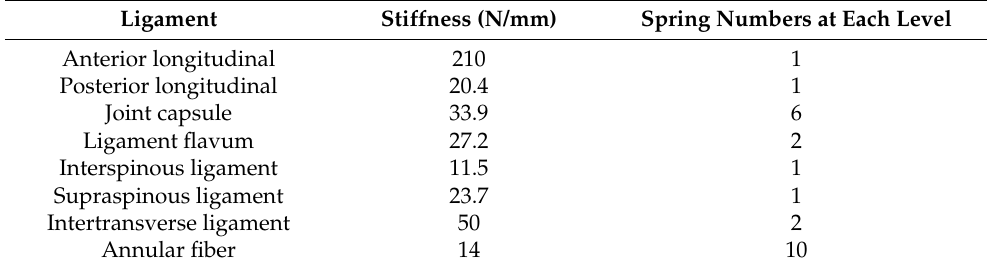
Table 1. The stiffness of the ligaments and annular fiber used in the simulation.